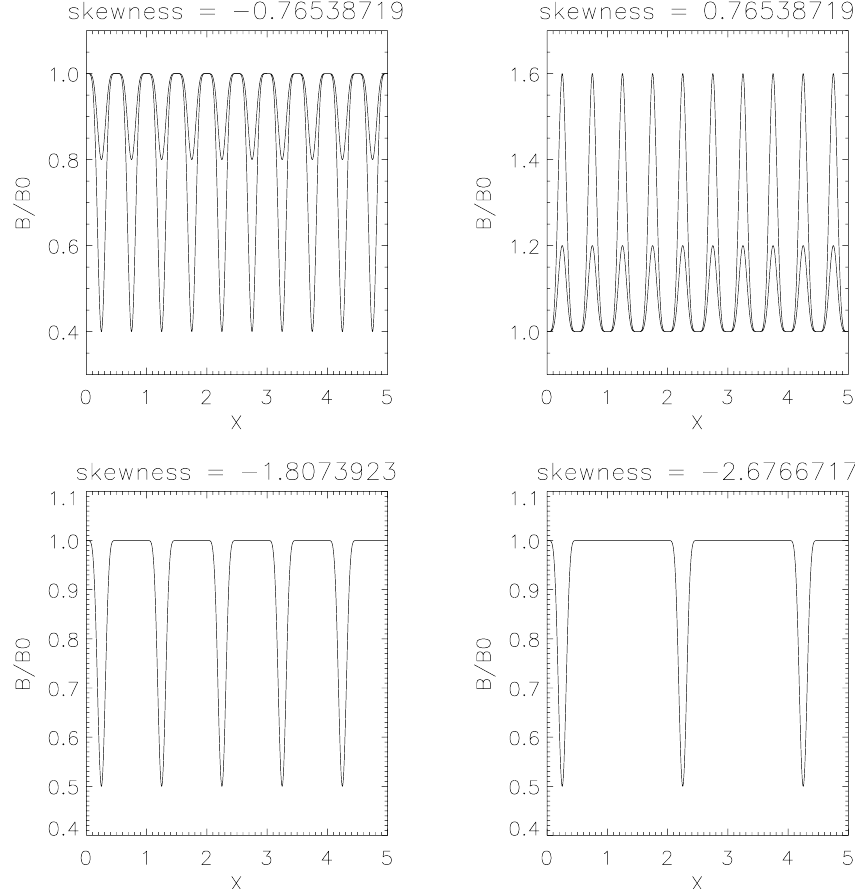
Fig. 1. Skewnesses of composite peak and hole structures obtained by varying the fluctuation amplitudes (top panels) and the number of structures on a given interval (bottom panels). Abscissae are